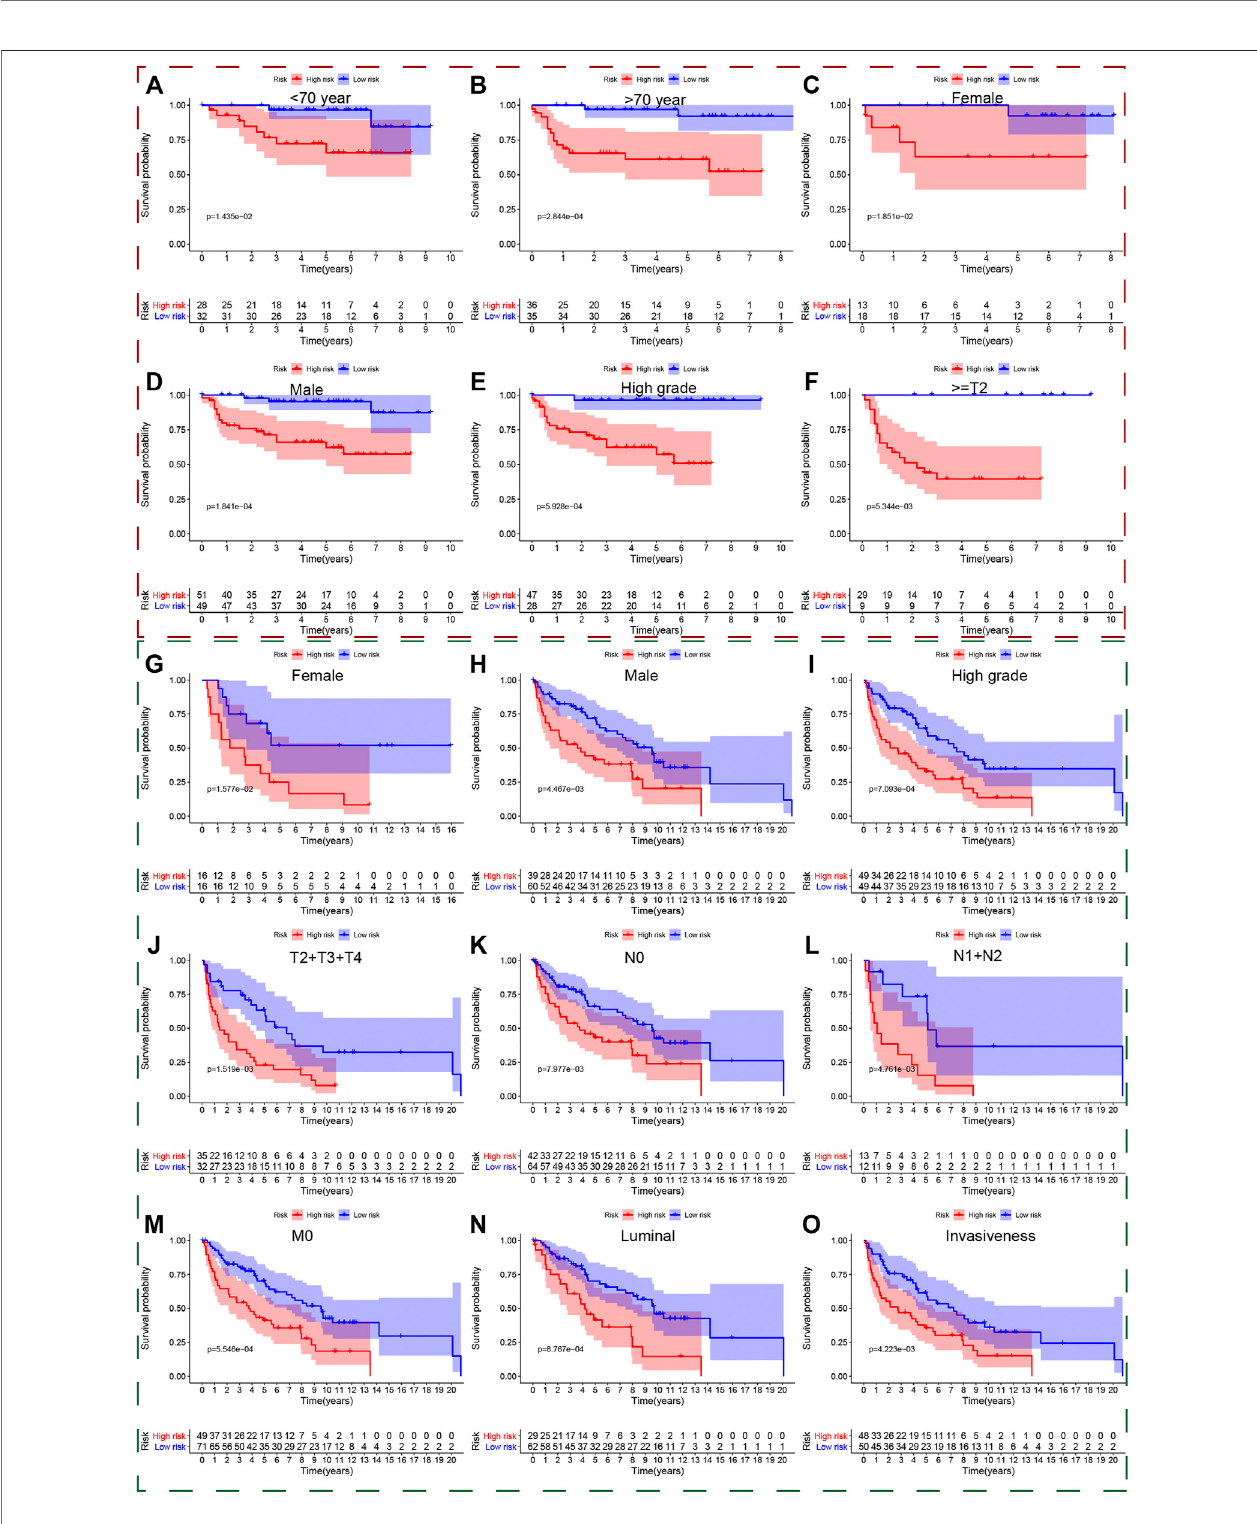
FIGURE 6 | The survival outcomes of bladder cancer patients with different risk scores in subgroups of clinicopathological parameters in GSE32548and GSE48075. The red and green, dashed boxes corresponded to the subgroups in GSE32548 and GSE48075, respectively. Patients with higher risk scores had worse overall survival compared with those with lower risk scores in subgroups of (A) age < 70, (B) age ≥ 70, (C) female, (D) male, (E) high grade, and (F) high T-stage in GSE32548; in the subgroups of (G) female, (H) male, (I) high grade, (J) muscle-invasive bladder cancer, (K) nodal metastasis-free, (L) nodal metastasis, (M) metastasis-free, (N) luminal subtype, and (O) invasiveness in GSE48075.